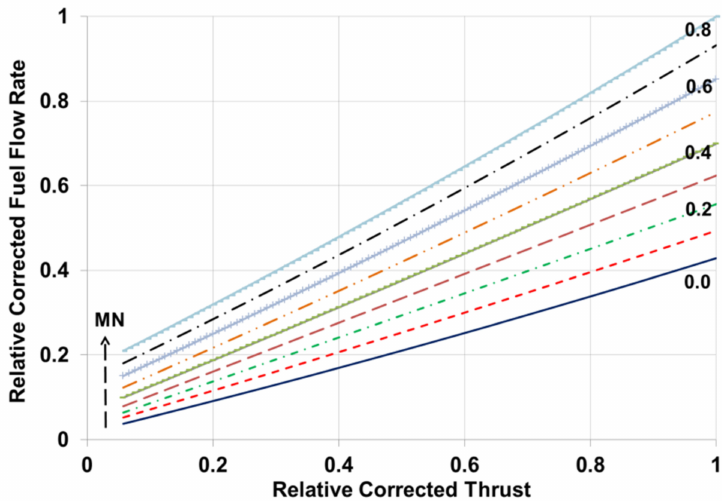
Figure 3. Engine performance matrix for an EIS-2016